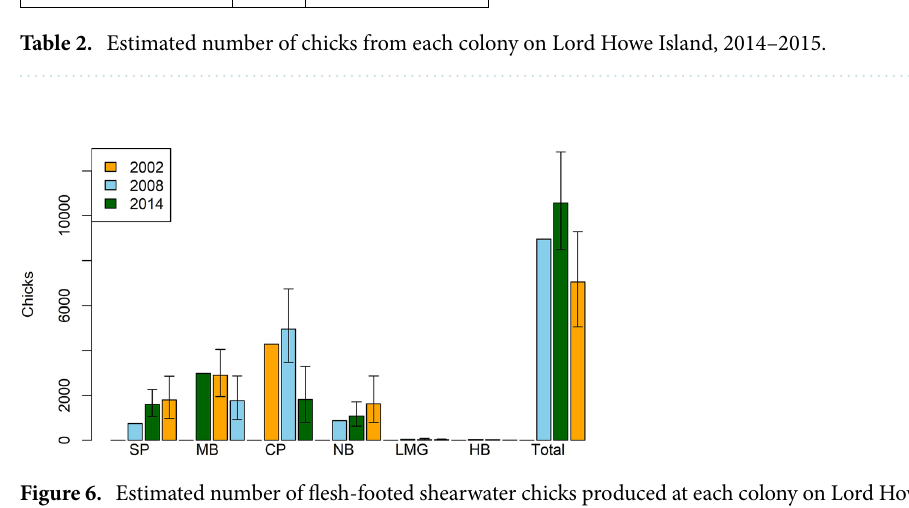
Figure 6. Estimated number of flesh-footed shearwater chicks produced at each colony on Lord Howe Island (SP, Stevens Point; MB, Middle Beach; CP, Clear Place; NB, Neds Beach; LMBG, Little Muttonbird Ground; HB, Hunter Bay). (Confidence intervals for 2008 and 2014 is 95% Credible interval, no confidence intervals were indicated for 2002 by 9 .